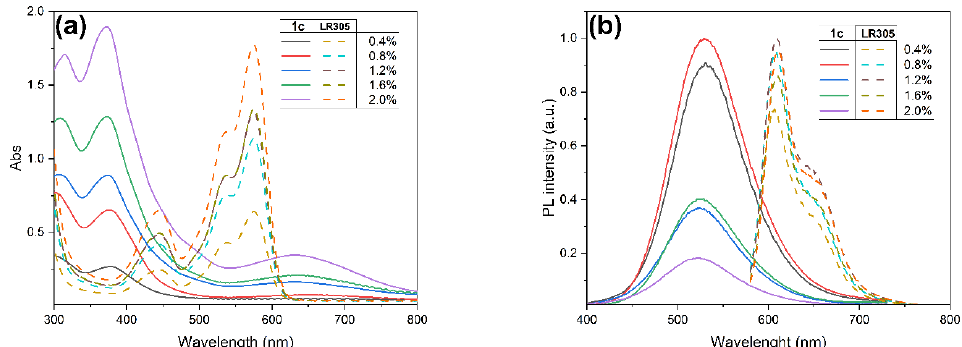
Figure 8. ( a ) Absorption spectra of 1c (solid line) and LR305 (dash line) in PMMA at different con- centrations (weight %); ( b ) fluorescence emission spectra of 1c (solid line, excitation at 372 nm) and